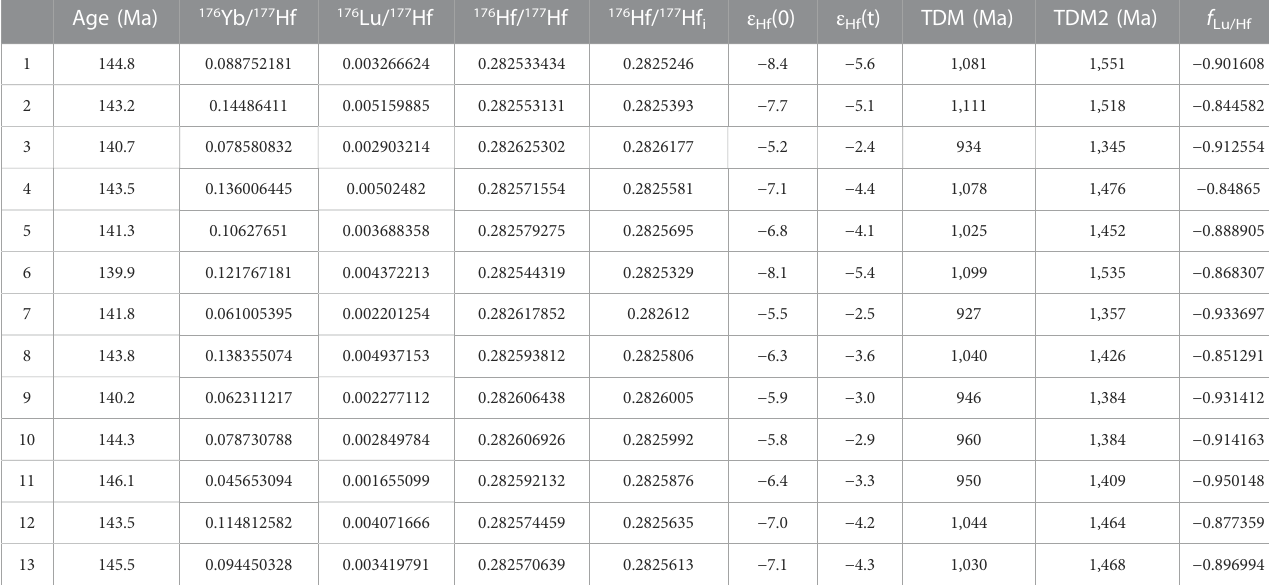
TABLE 4 Hf isotope ratios of the zircons from